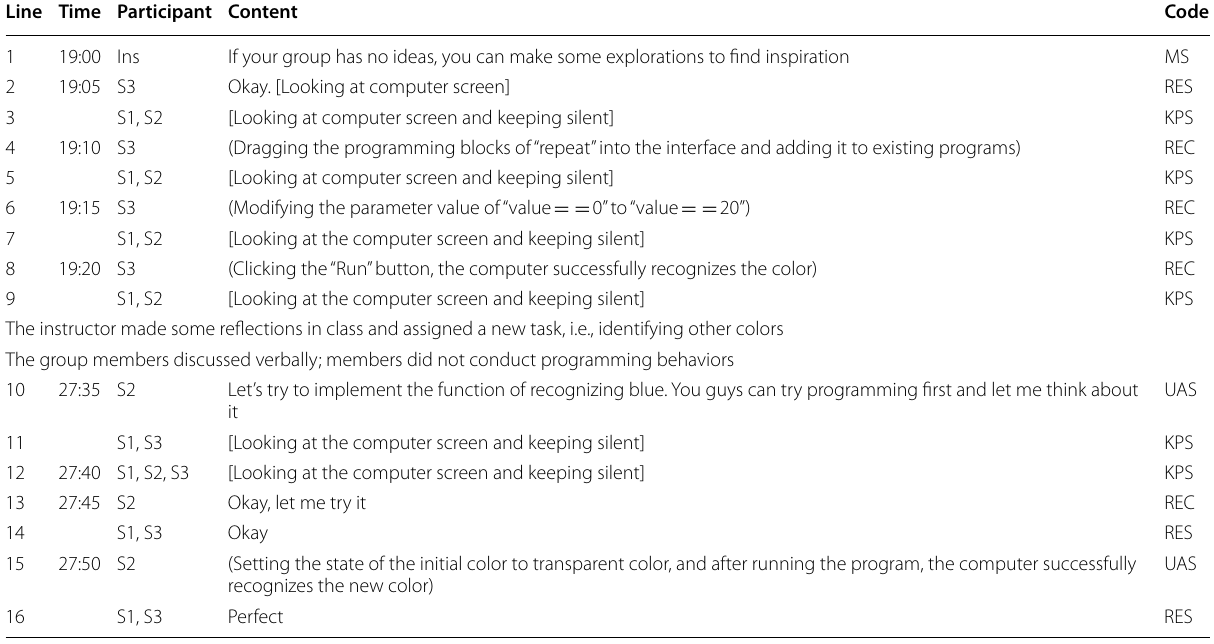
Texts in “()” indicated that group students’ computer programming operations; texts in “[]” indicated students’ in-class behaviors; other texts were transcribed communication content